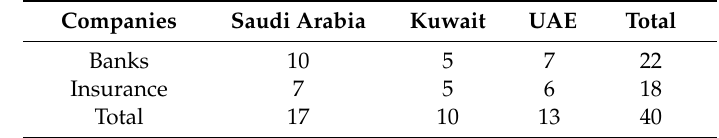
Figure 3. Major players of M&As. Table 2. Profile of respondents.